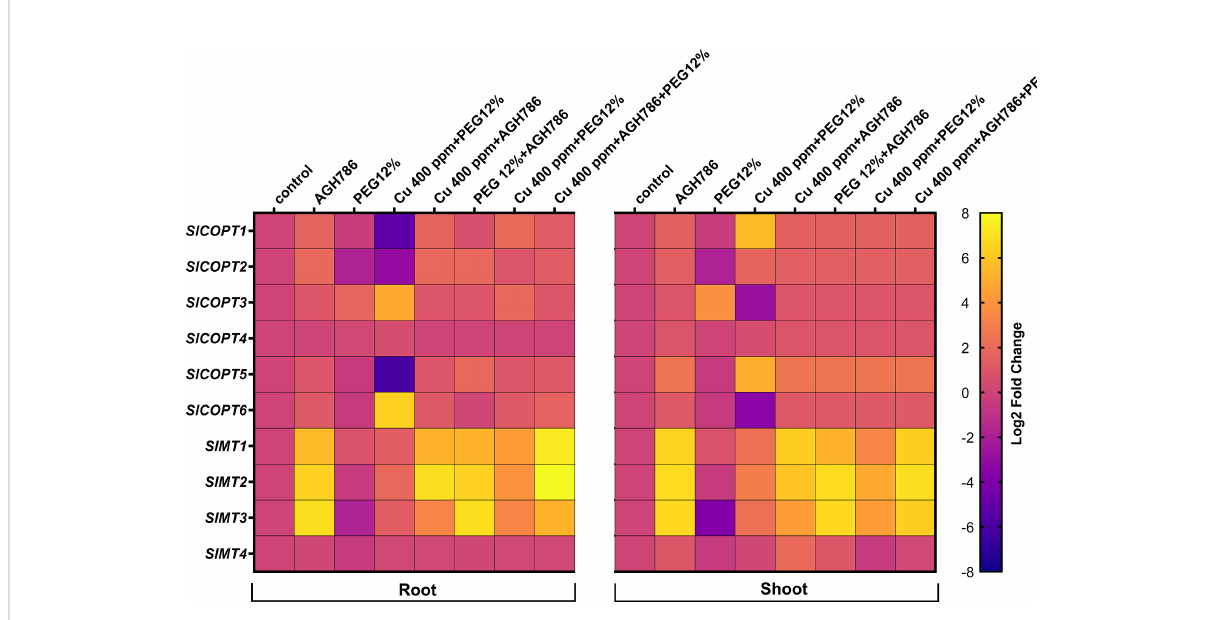
FIGURE 9 Differential expression pro fi le of SlCOPT and SlMT genes by Reverse transcription – quantitative PCR in the root and shoot tissues of S. lycopersicum L. subjected to the single and combined stress of Cu and drought inoculated with AGH786 compared with the control. Quantitative data represent the means ± standard deviation of three independent experiments and at least three technical replicates